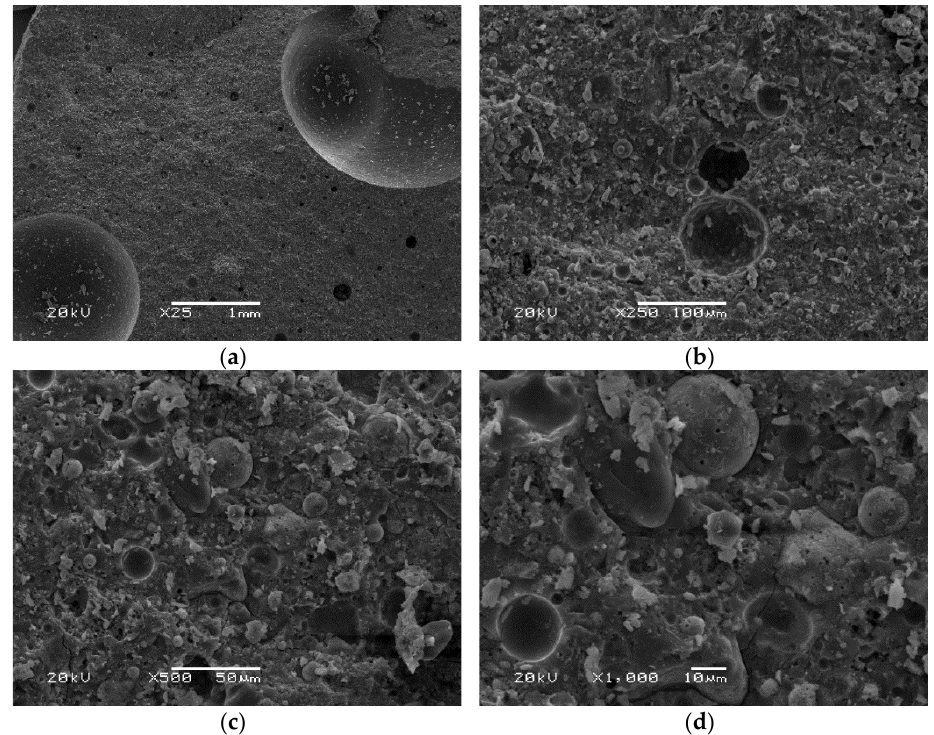
Figure 7. SEM pictures of materials based on conventional fly ash obtained from Skawina Power Plant (F) in magnification: ( a ) 25×; ( b ) 250×; ( c ) 500×; ( d ) 1000×.